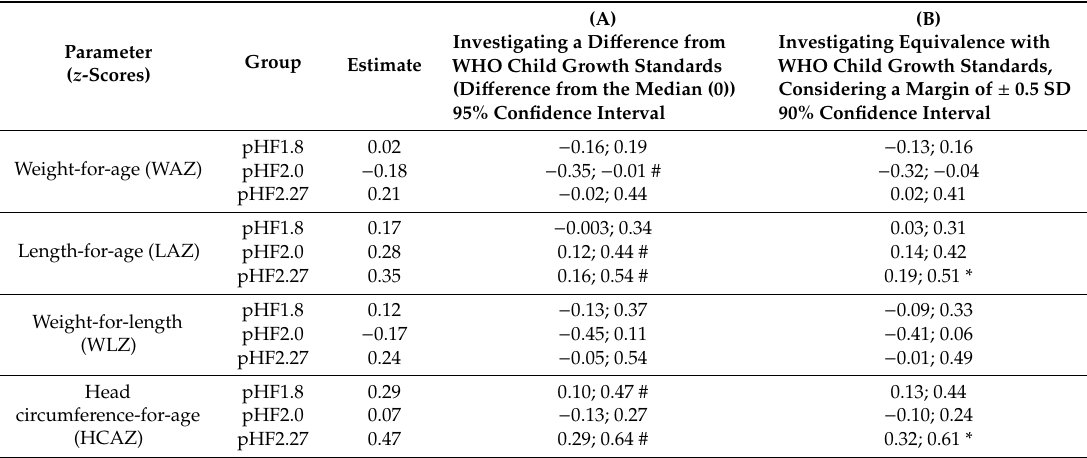
Table 2. Estimated means of change in z -score of growth outcome parameters from baseline to 4 months of the PP population for (A) differences from WHO Child Growth Standards based on 95% CI and (B) equivalence with WHO Child Growth Standards based on 90% CI.